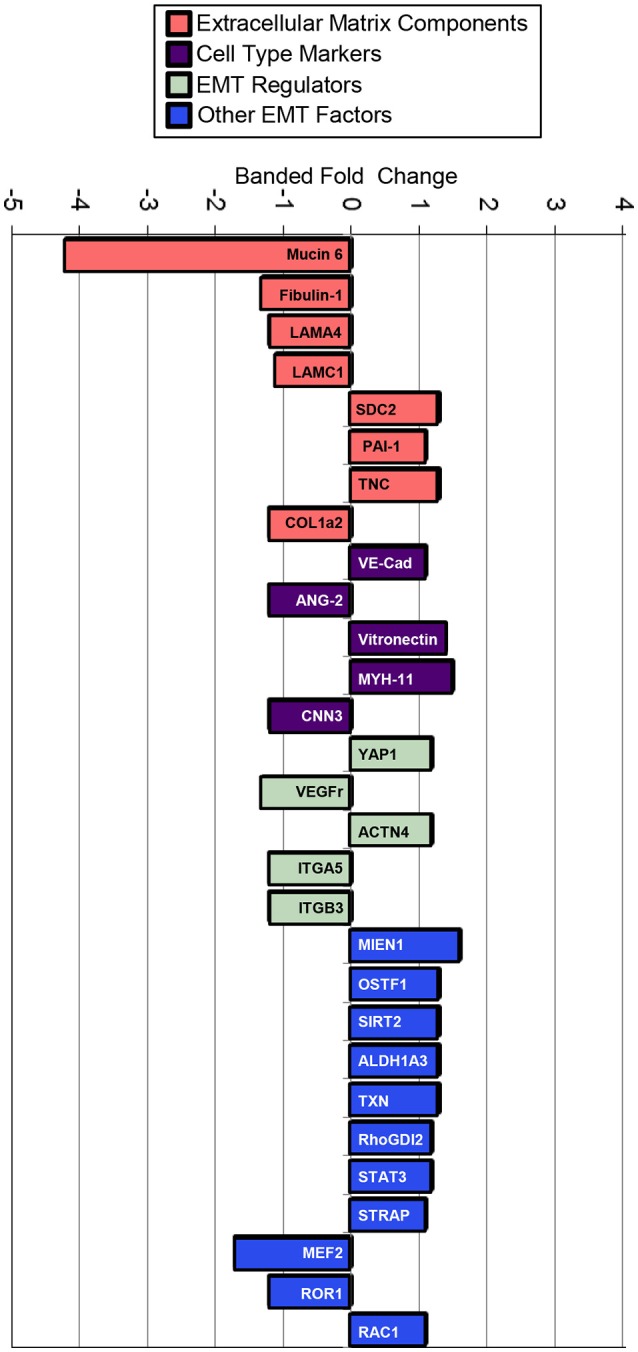
Fold changes in mass-spectrometry measured protein abundances in banded samples compared to controls that are associated with EMT. Extracellular matrix proteins, cell type markers, EMT regulators, and factors associated with other types of EMT are shown, with positive and negative fold changes representing protein upregulation and downregulation, respectively. Protein abbreviations are listed in Tables 1, 2.